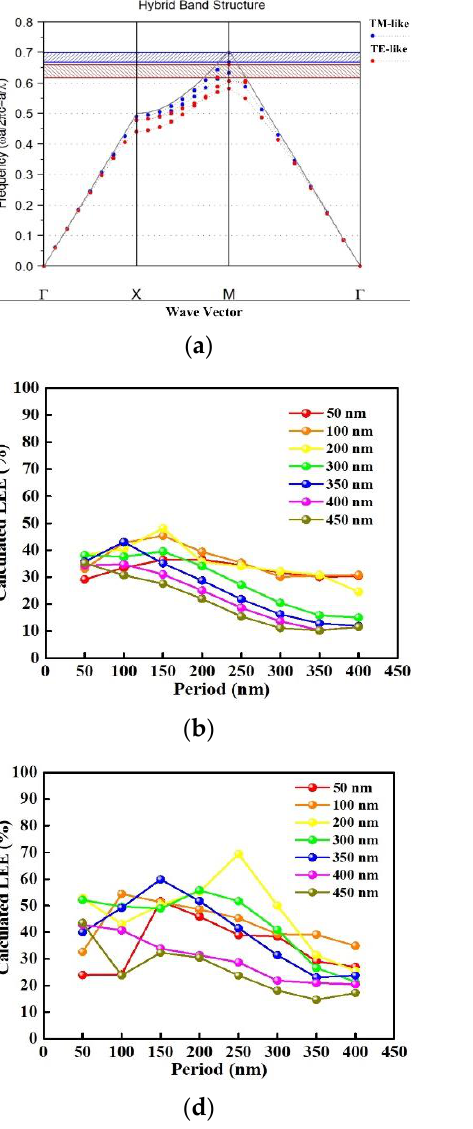
Figure 4. ( a ) The band diagram of PC-structured p-GaN nanorods and the calculated LEE of the PC-structured p-GaN nanorods with the varied period and diameter at a height of ( b ) 50 nm, ( c ) 90 nm, ( d ) 110 nm, and ( e ) 150 nm.